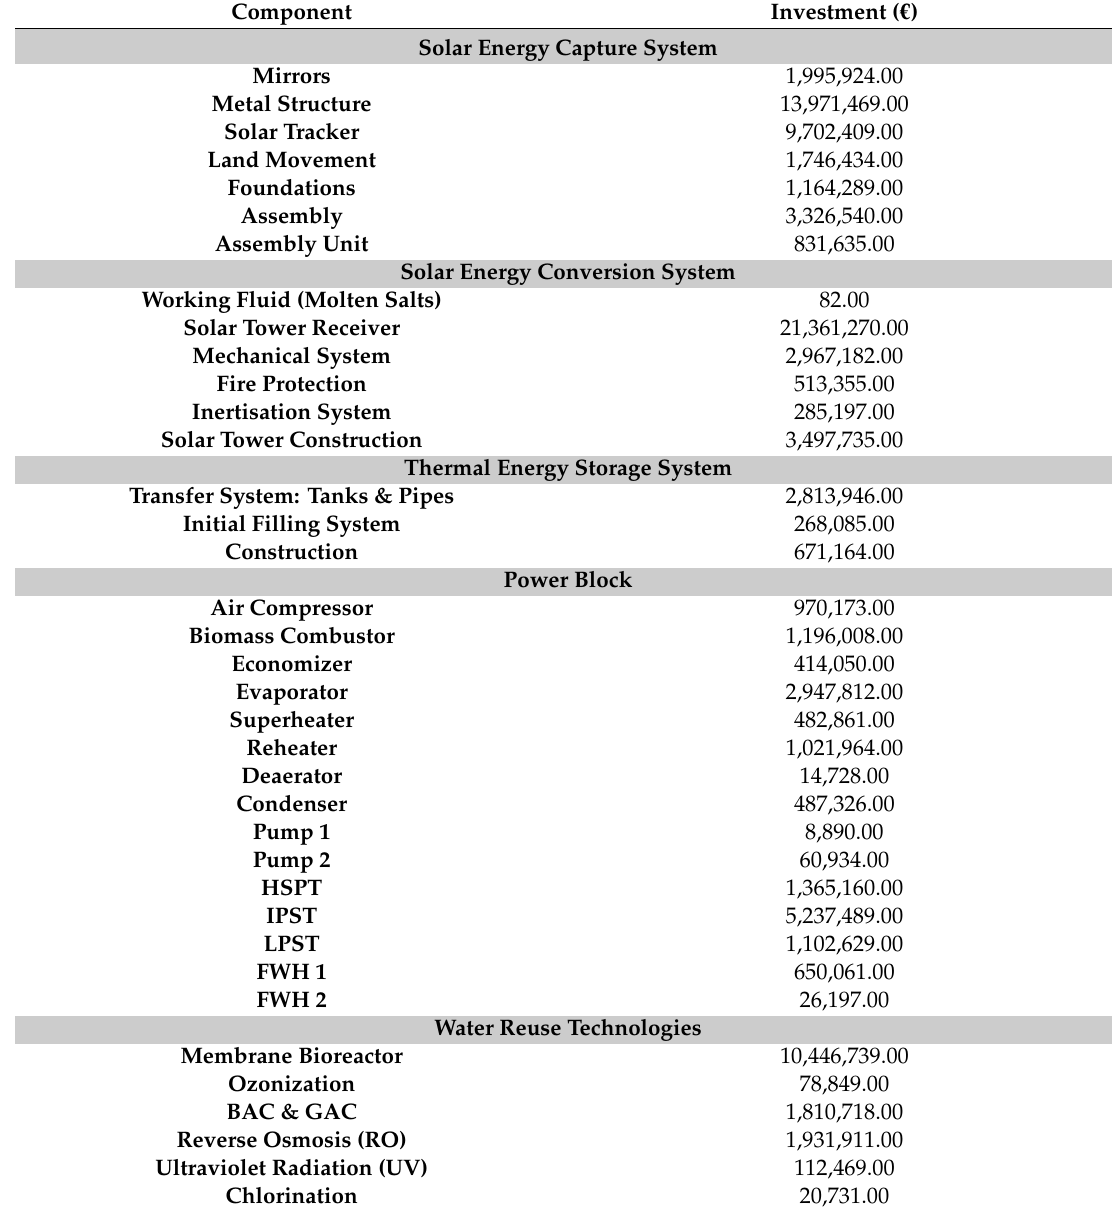
Table 3. Purchased equipment